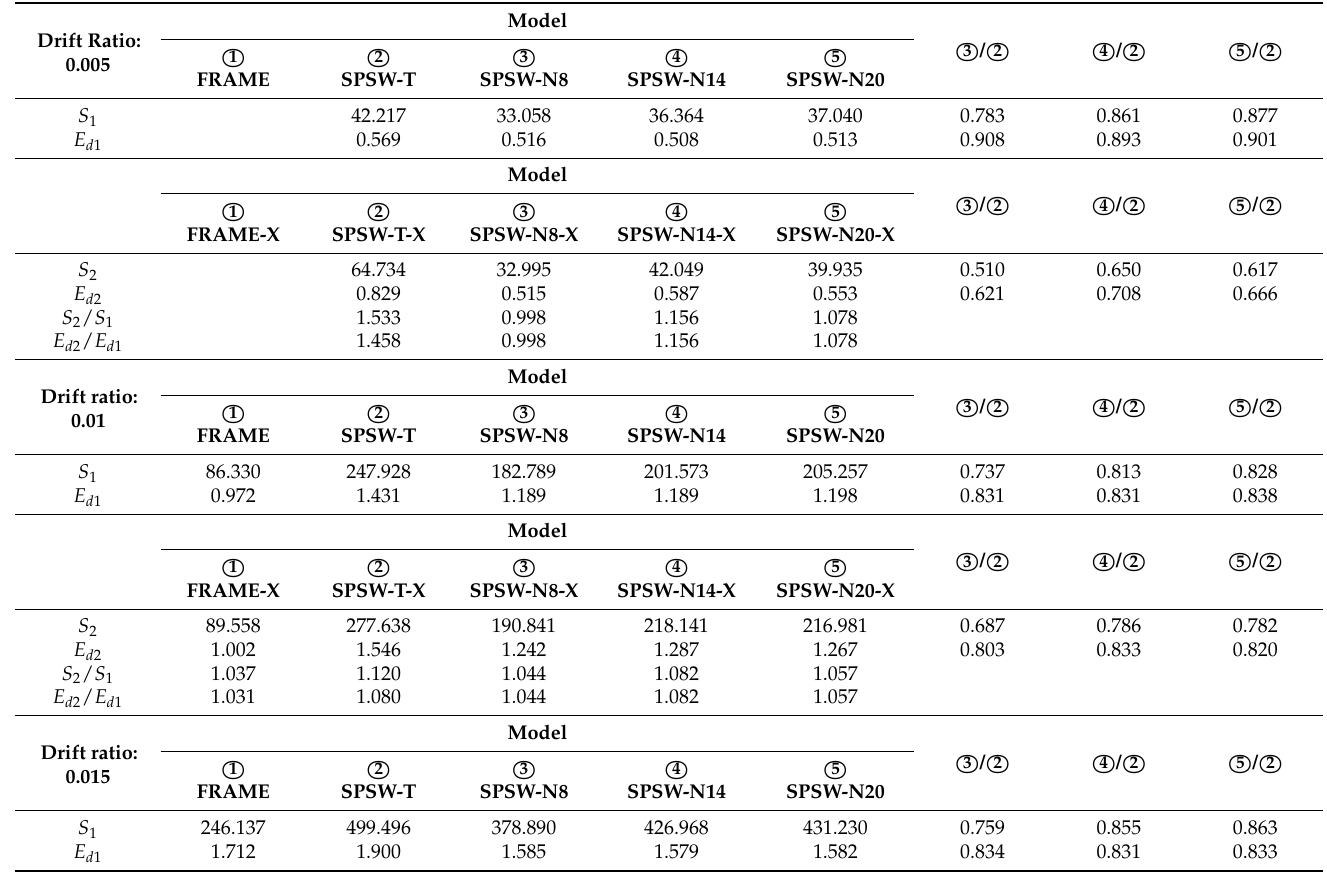
Table 9. Energy dissipation S and energy dissipation coefficient E d of each model under all levels of cyclic loading